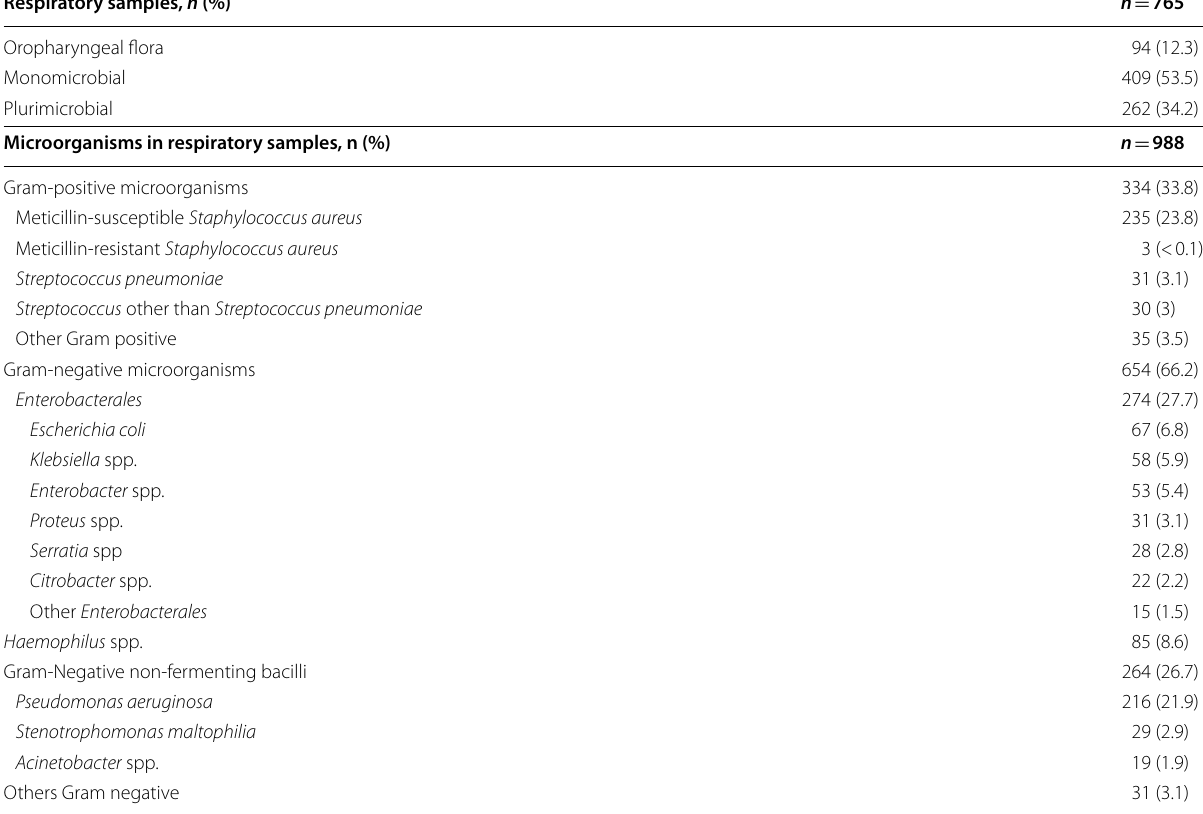
Table 3 Performance of screening for ESBL-E, HLAC-E and 3GCR-E (ESBL-E and/or HLAC-E) intestinal carriage as predictor of their absence/presence in respiratory samples